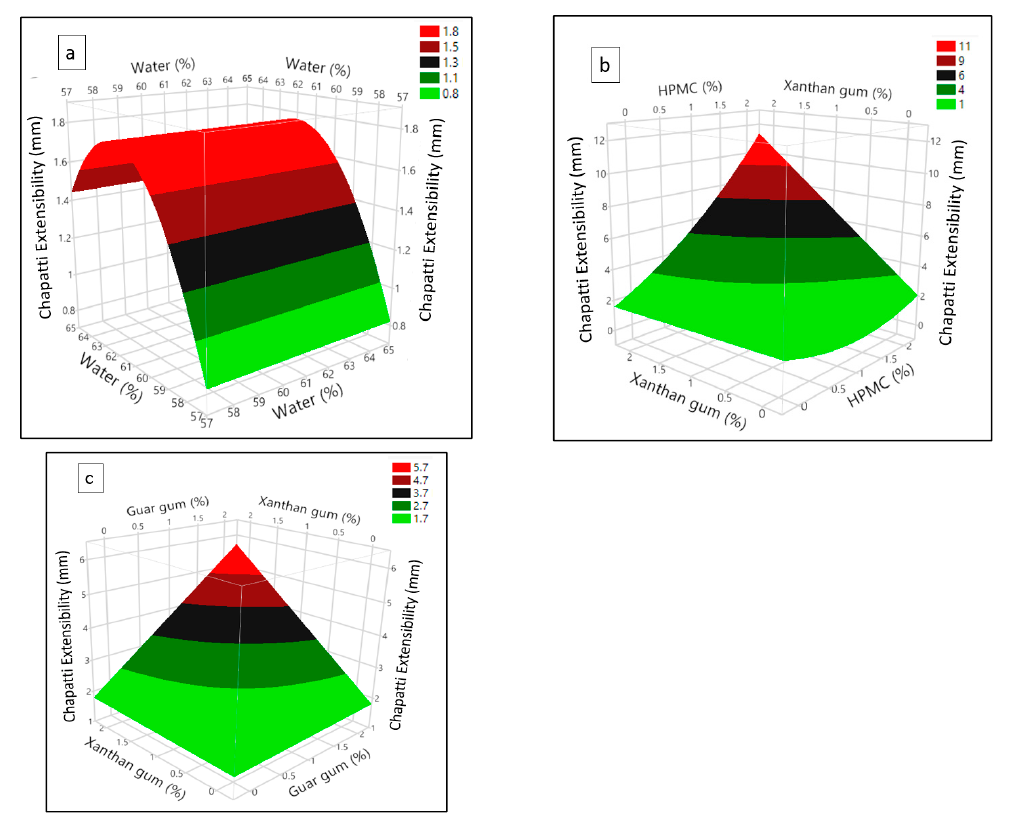
Figure 5. Surface plot depicting ( a ) quadratic effect of water, and interaction effect of ( b ) xanthan- HPMC, ( c ) xanthan-guar on wheat-cricket flour chapatti extensibility. HPMC, ( c ) xanthan-guar on wheat-cricket flour chapatti